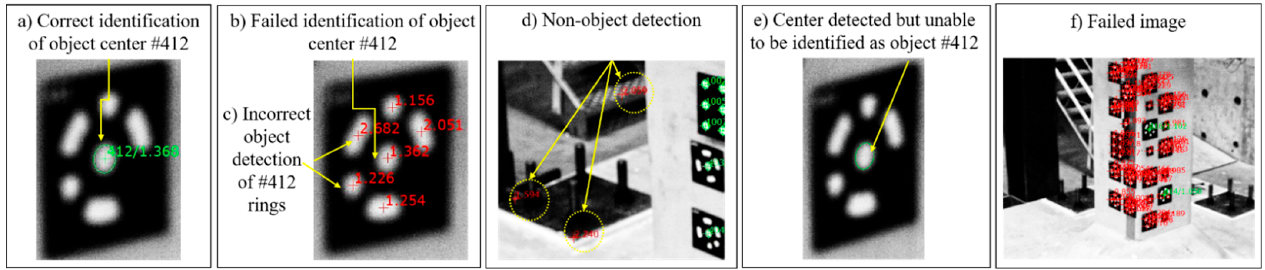
Figure 6. Examples of an automatic object and non ‐ object detection, identification, and positioning in the photogrammetry procedure.